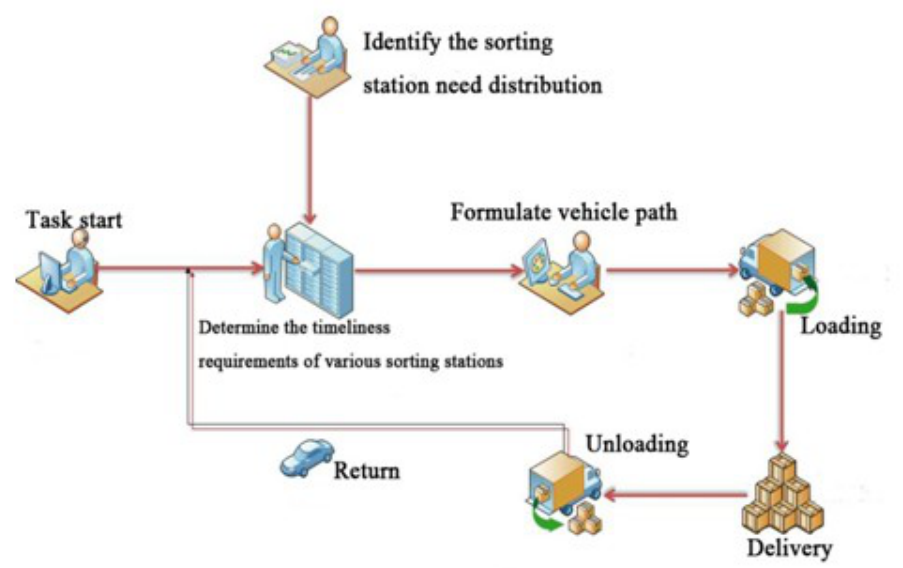
Figure 5. The process of Multiple dynamic Saving